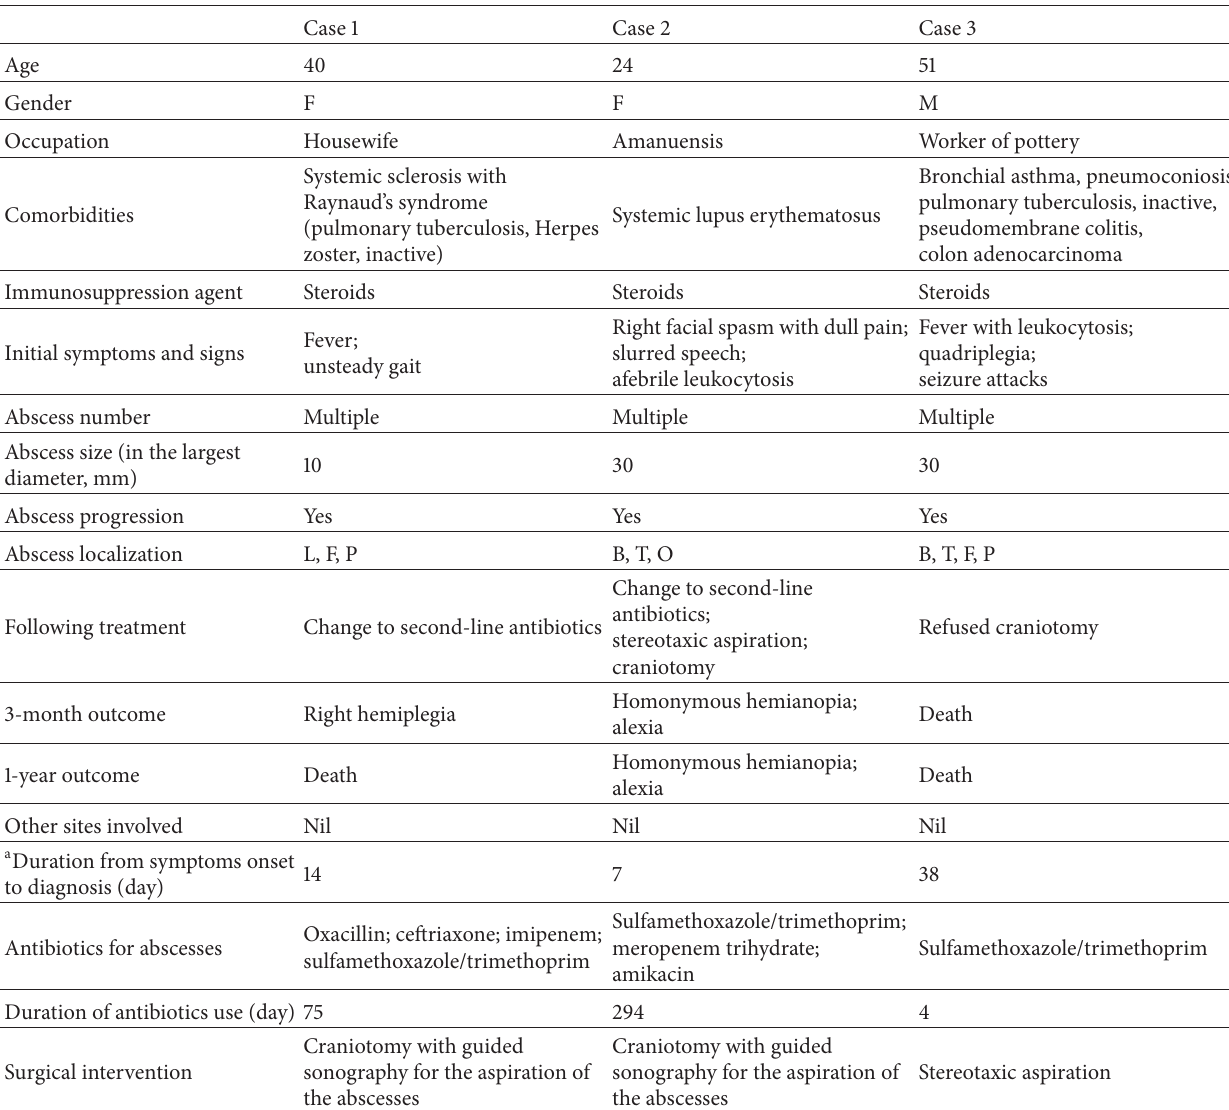
Table 1: Summary of patient